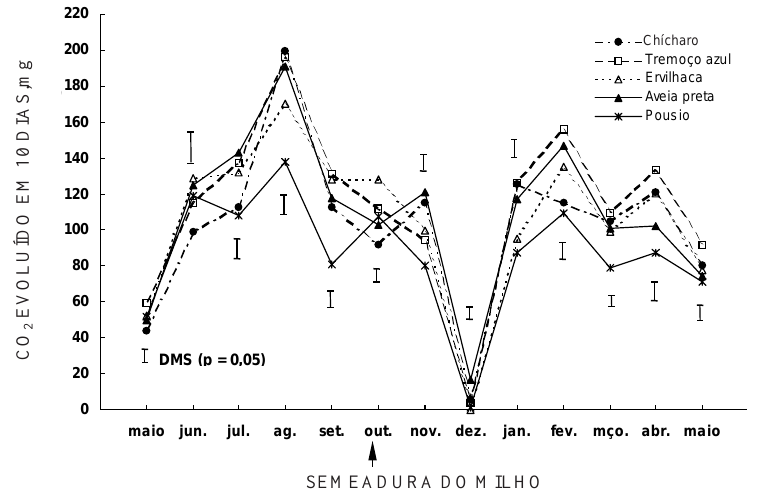
Figura 2. Variação temporal da evolução de CO no solo, na camada de 0-5 cm, sob diferentes plantas de 2 cobertura do solo antecendendo a cultura do milho em plantio direto. Diferença mínima significativa (DMS) pelo teste t (p =